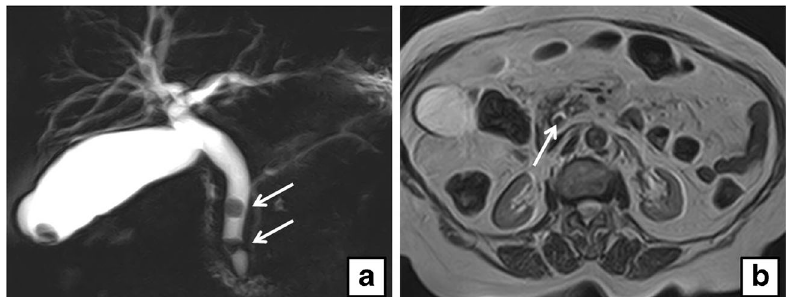
Fig. 2 a Coronal maximum intensity projection (MIP) reformat shows two filling defects in a dilated CBD ( arrows ) and one inthe gallbladder. b Axial T2- weighted MRI of the same patient shows a filling defect in a dilated CBD ( arrow )